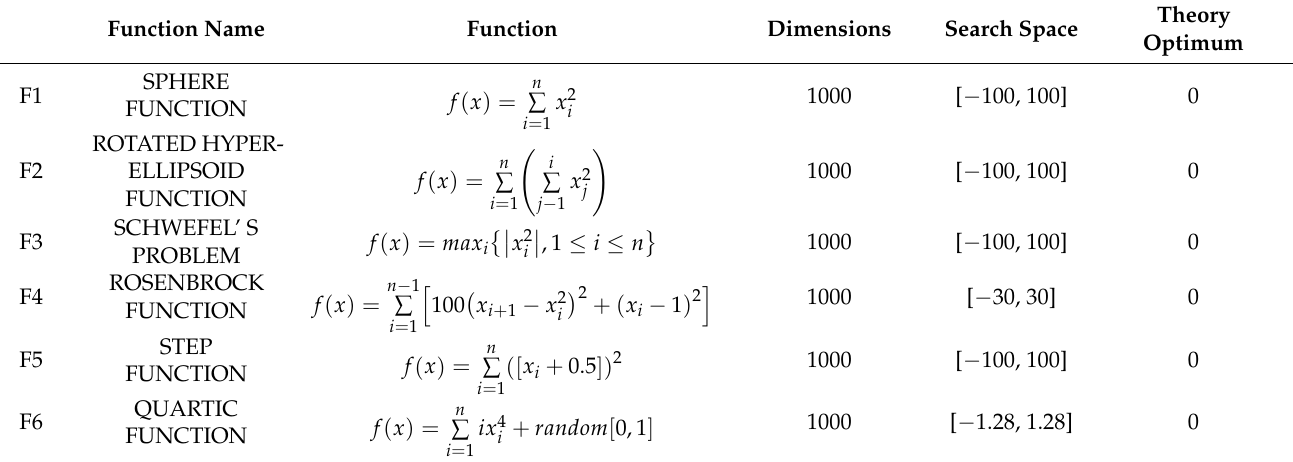
Table 1. High-dimensional unimodal benchmark test functions.